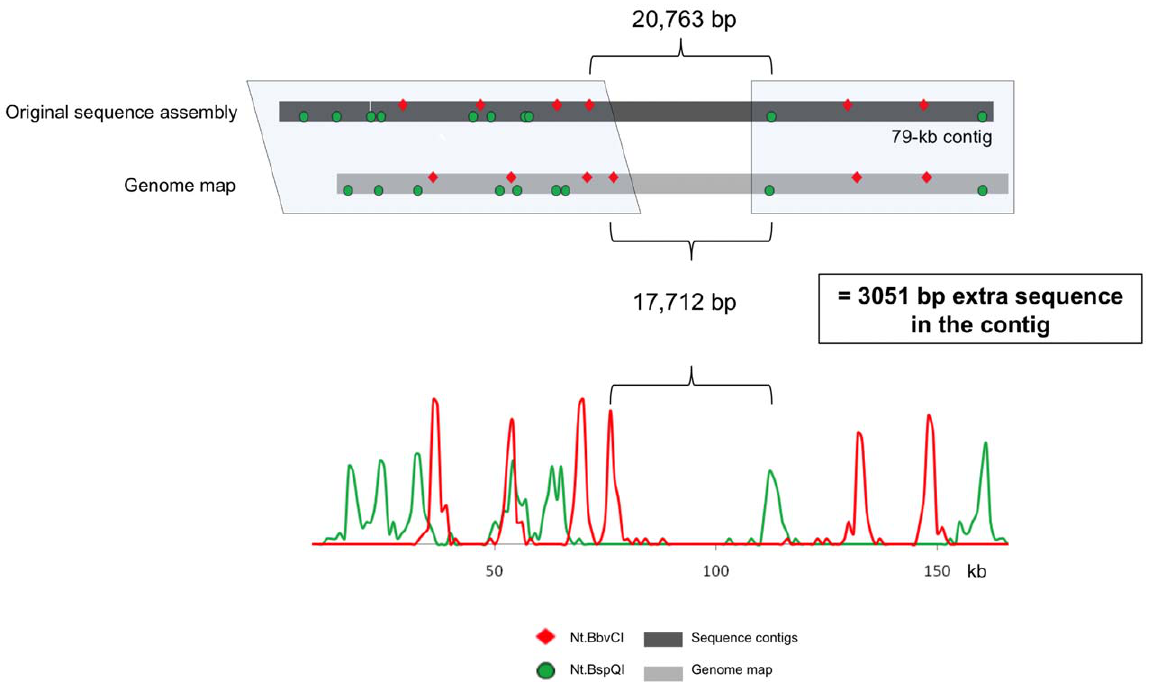
Figure 5. Contig assembly error identification through genome map comparison. The top line represents the in silico map for the original sequence assembly, the majority of which is covered by a single sequence contig. The genome map matches on the left and right sides of the contig (shown with shaded boxes). , 3 kb of sequence was incorrectly inserted into the contig during assembly.